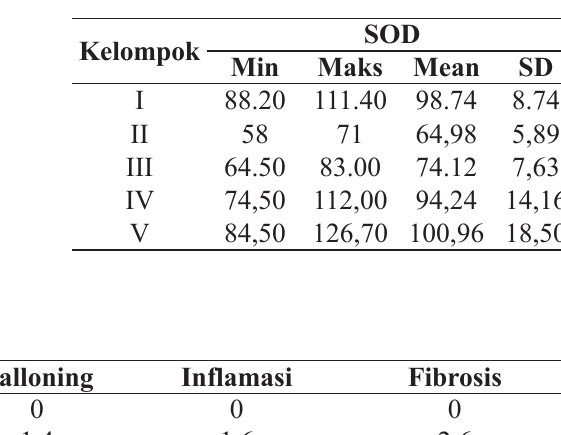
Tabel 1. Karakteristik rerata IL-6 tiap